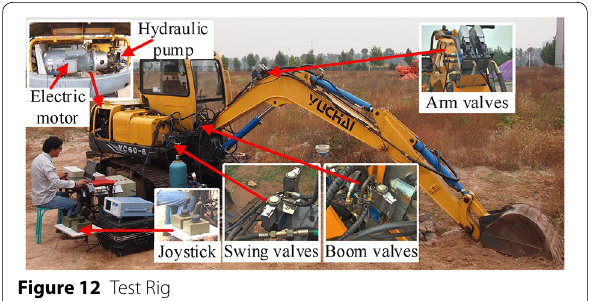
Figure 12 Test Rig